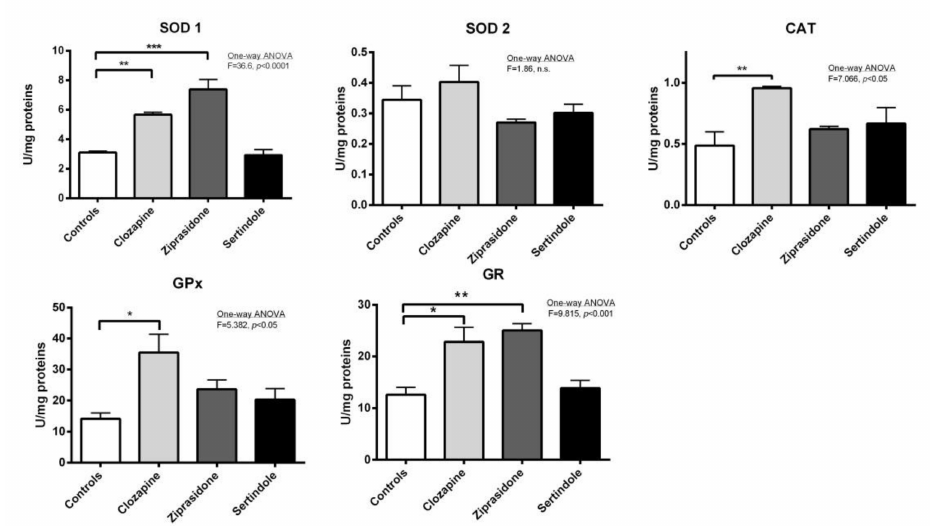
Figure 5. Activities of prostate antioxidant defence enzymes in rats after treatment with clozapine, ziprasidone and sertindole. SOD1, SOD2, CAT, GPx and GR activities were measured in control- and clozapine-, ziprasidone- and sertindole-treated rats. The values represent the means ± SEM. Statistical significance of the difference between experimental groups (one-way ANOVA): * p < 0.05, ** p < 0.001 and *** p <